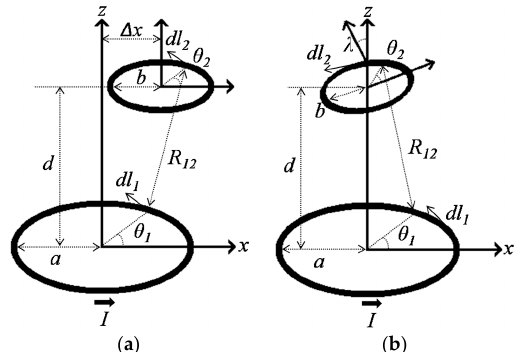
Figure 3. ( a ) Lateral misalignment configuration; ( b ) Angular misalignment configuration.